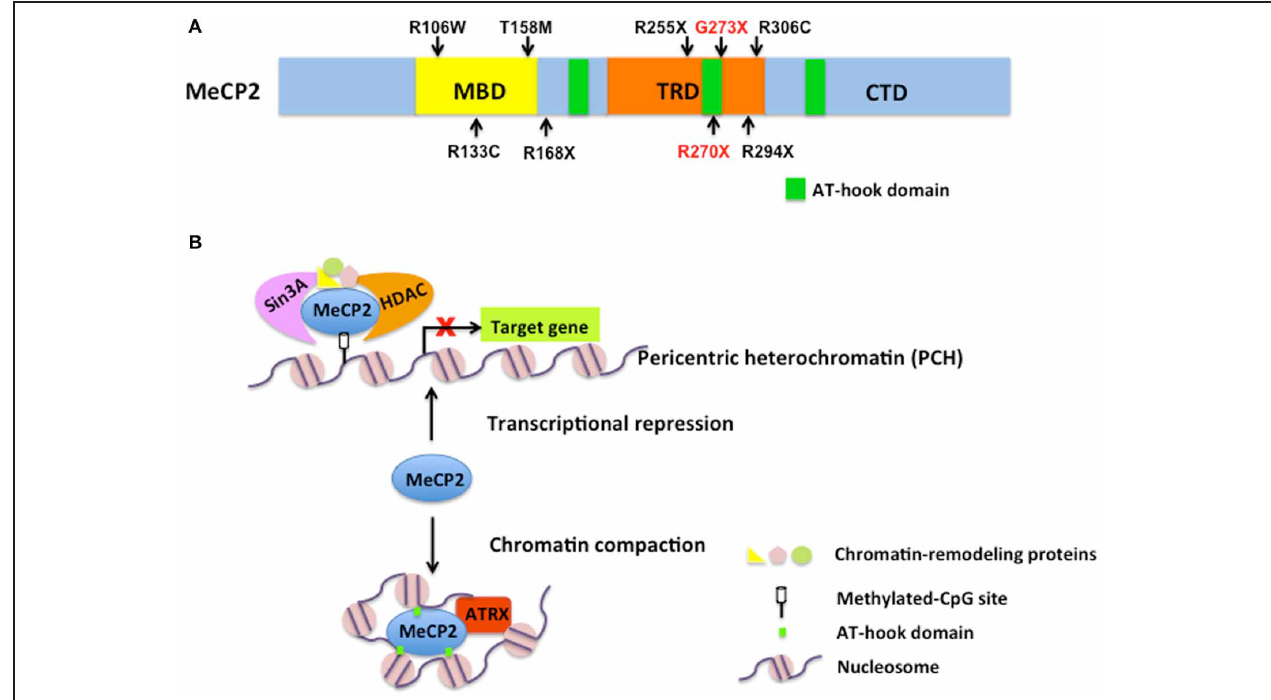
MeCP2 in transcription repression and chromatin compaction. As a transcriptional repressor, MeCP2 recruits Sin3A, histone deacetylases (HDACs), and some chromatin-remodeling proteins to silence target gene transcription. Also, Baker et al. (2013) discovered that AT-hook clusters facilitate MeCP2 to alter chromatin conformation by recruitment of ATRX to PCH to maintain chromatin